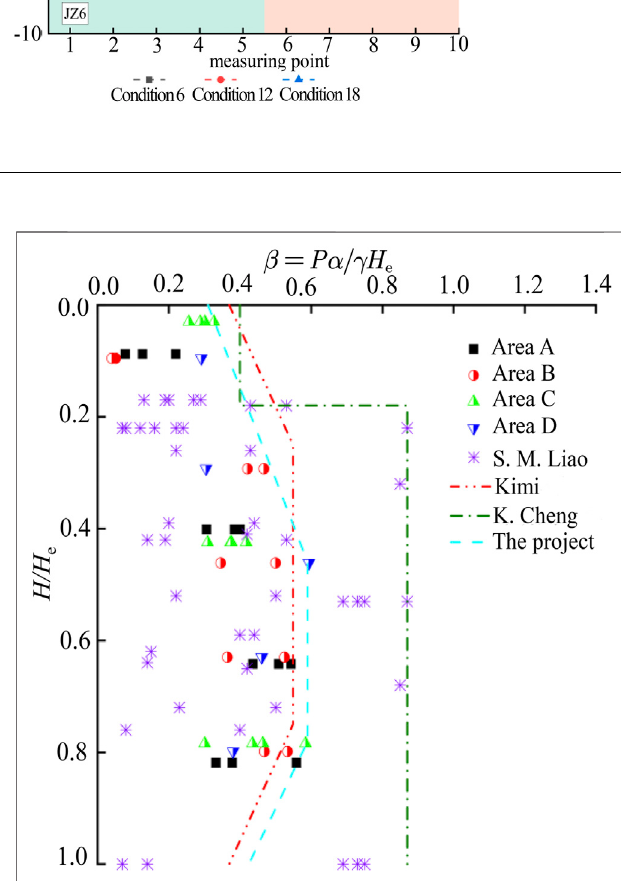
FIGURE 12 | Apparent earth pressure envelope of the foundation